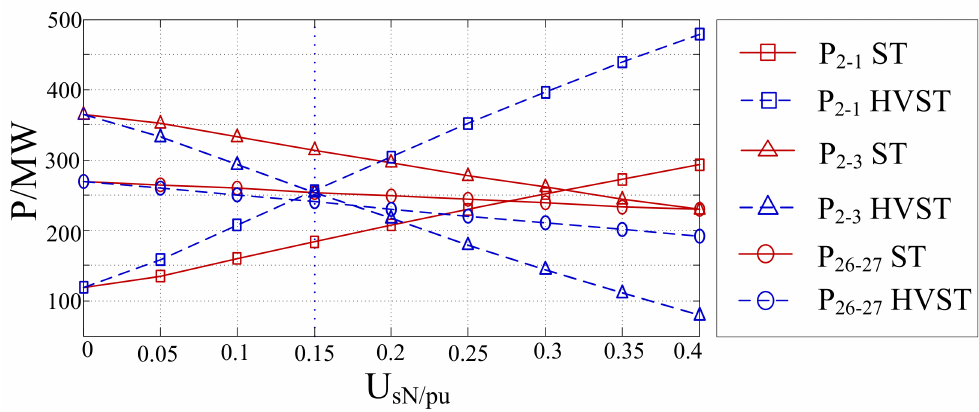
Figure 14. The transmission active power flows of lines 2-1, 2-3, 26-27 at various U sN for the ST and the